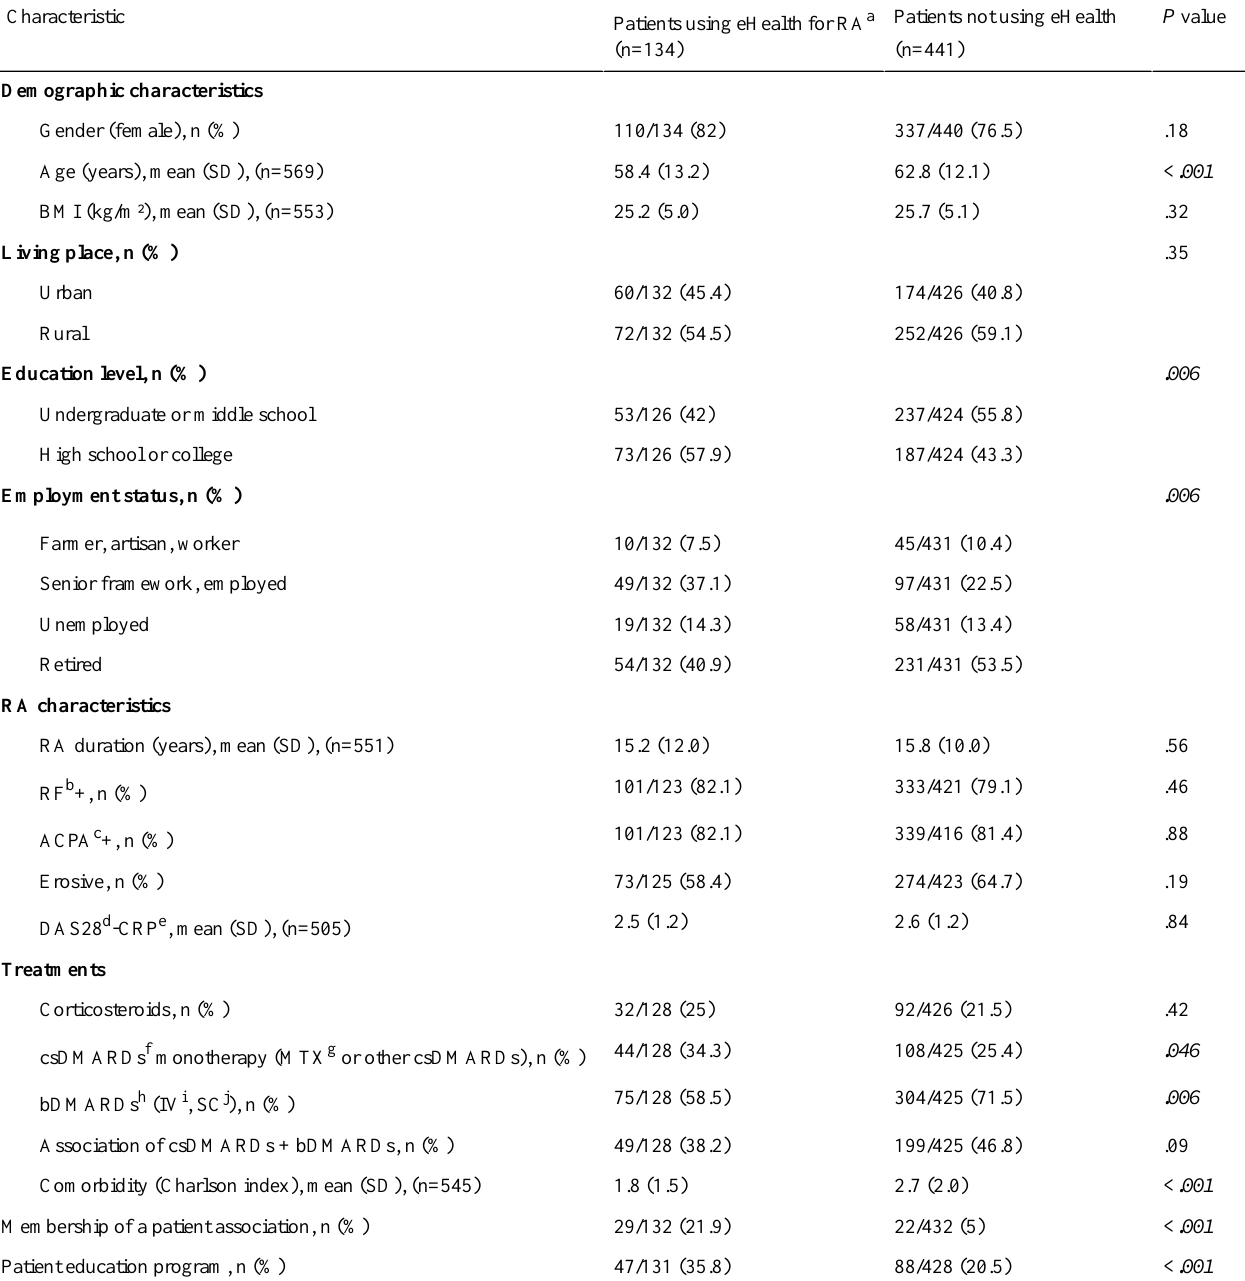
Table 2. Patient characteristics and factors associated with the use of eHealth tools. Italicized values indicate statistically significant values.